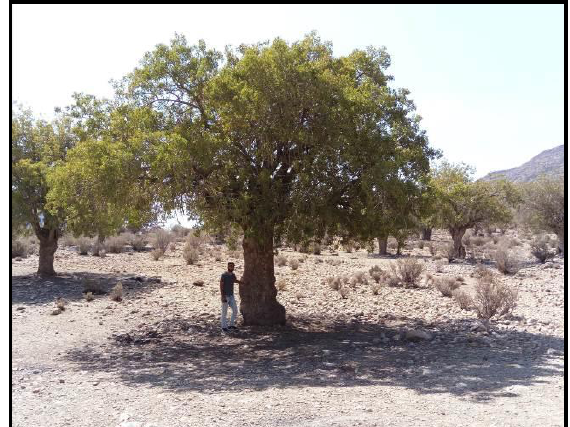
wild almond shrubs (Fig. 3).